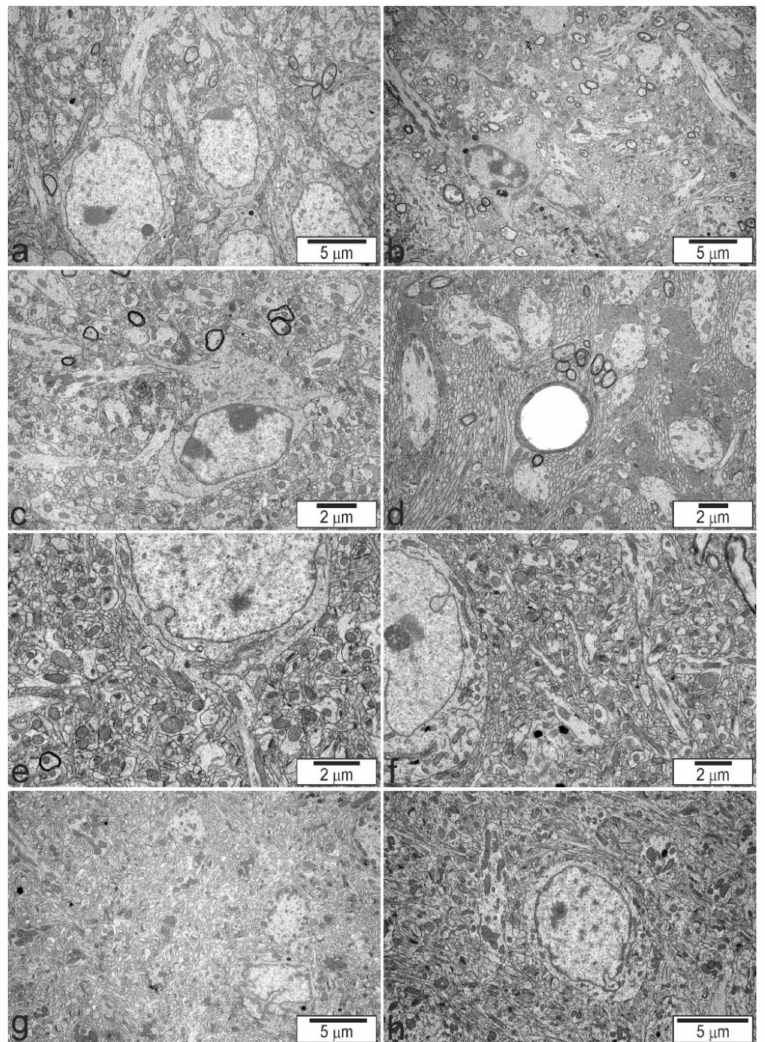
Figure 3. The effect of Tsc2 haploinsufficiency on the ultrastructure of neuronal cells in the CA1/CA2 ( a , b ). and CA2/CA3 ( c , d ) regions of the hippocampus, brain cortex ( e , f ), and cerebellum ( g , h ). ( a , c , e , g )—control group Tsc2 +/+ ; ( b , d , f , h )—Tsc2 +/ − group. Typical electronograms at low magnifica- tion are